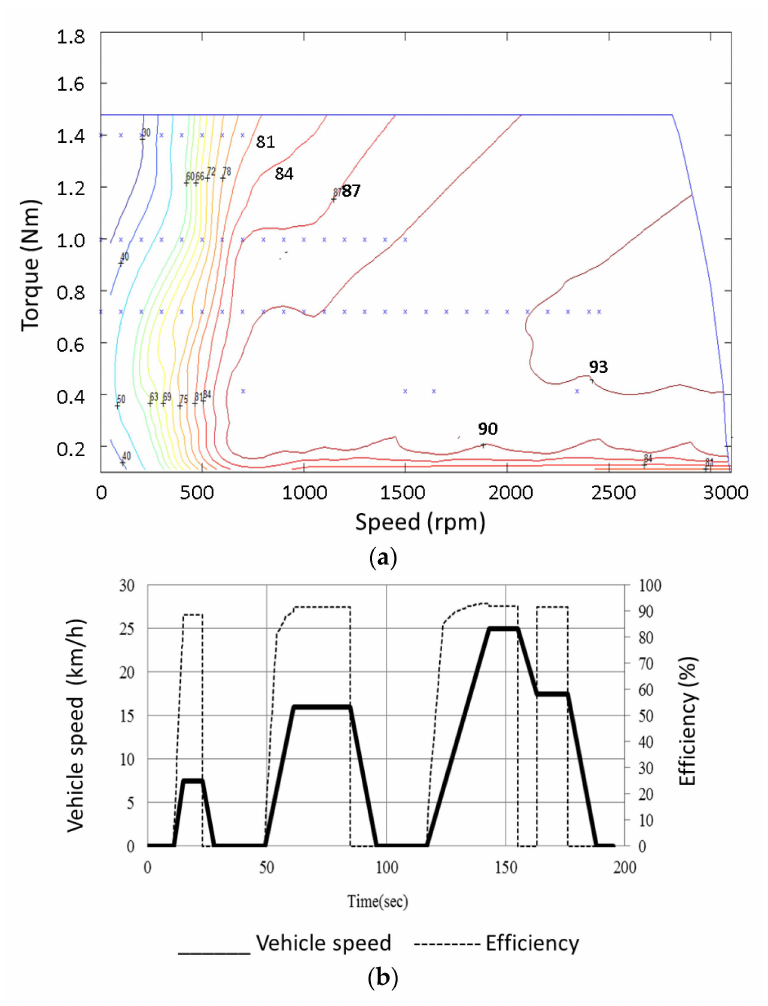
Figure 8. ( a ) Driving points on the efficiency map estimated by the FE analysis; ( b ) The efficiency history along the ECE-40 driving